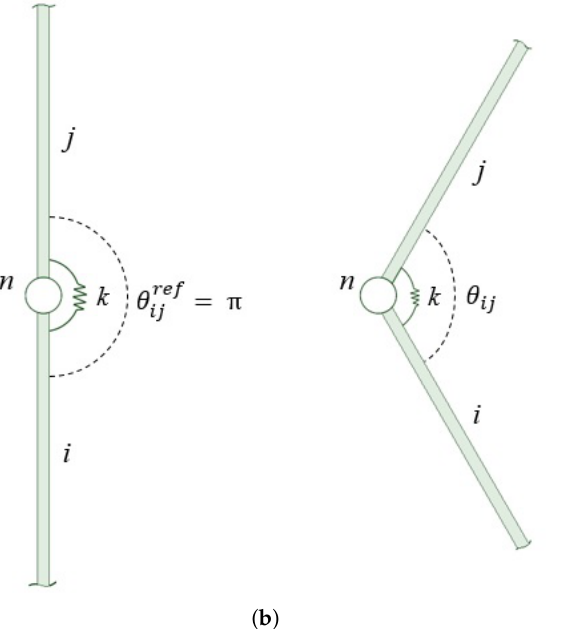
Figure 1. A representation of the n -th flexure hinge ( a ) and its PRBM schematization ( b